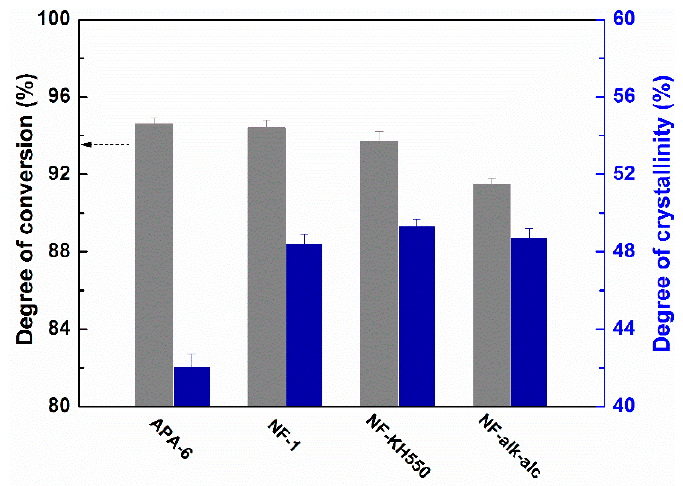
Figure 8. The degree of conversion (gray columnar) and crystallinity of different modified ramie fabrics reinforced APA-6 composites (blue columnar).